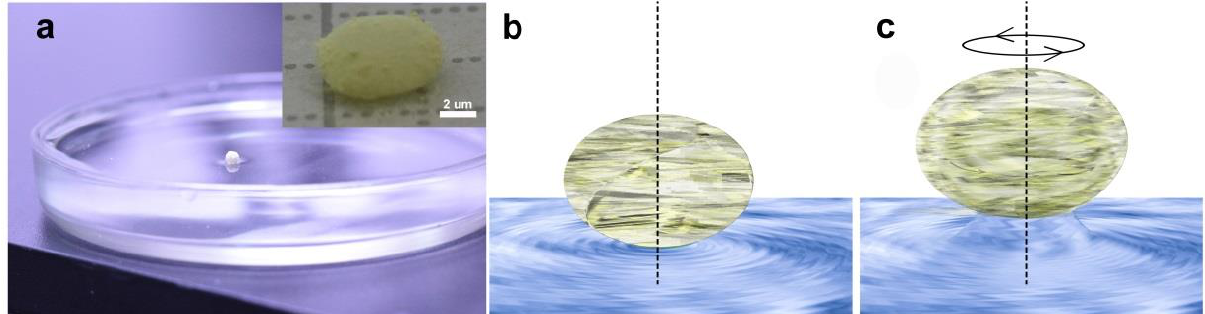
Figure 3. Time dependence of the speed of pulsed rotation for liquid marbles with different weights: ( a ) 6.5 mg; ( b ) 14.5 mg.